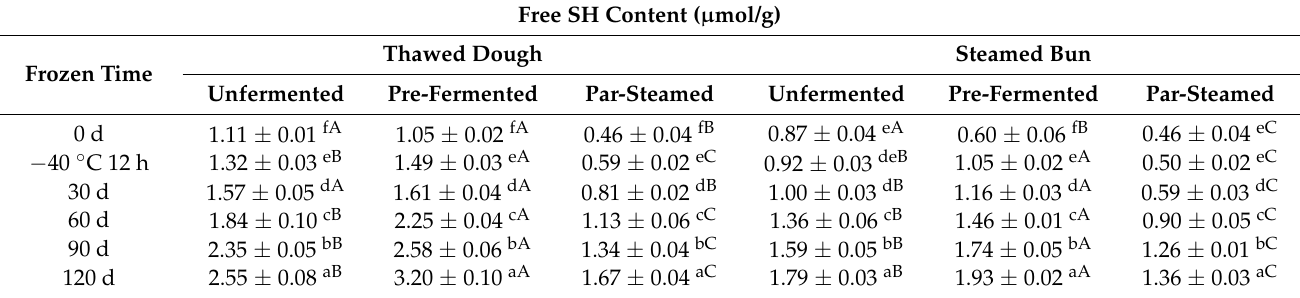
Table 3. Effects of frozen storage time on free SH content of thawed dough and steamed buns.